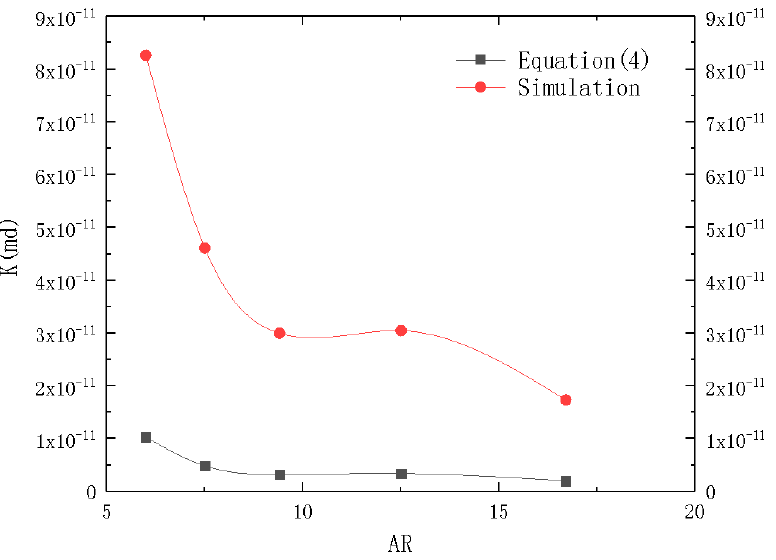
Figure 2. Plot of permeability (K) depending on aspect-ratio (AR).